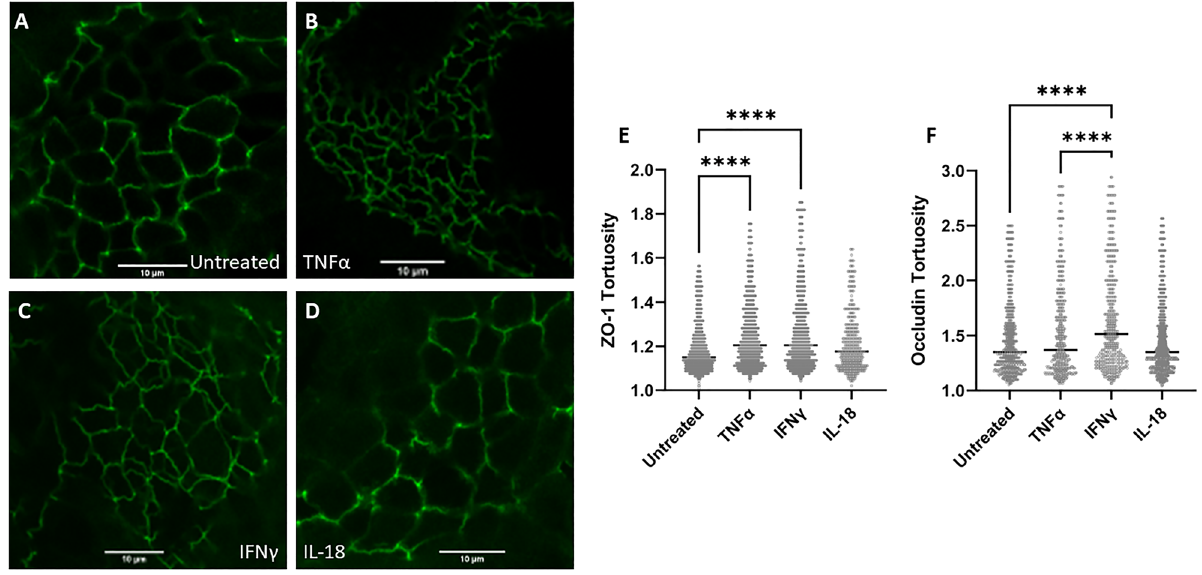
Figure 4. Cytokine treatment alters tight junction tortuosity. ( A–D ) Representative ZO-1 (Alexa Fluor 488) staining of bovine intestinal organoids using a ×100 objective lens following 24-h cytokine treatment. Scale bars denote 10 µm. ( E ) Quantification of ZO-1 tortuosity in cytokine-treated intestinal organoids. TNFα-treated bovine enteroids and IFNγ-treated bovine enteroids displayed a significant increase in junctional tortuosity (p < 0.0001 for each treatment) determined by Kruskal–Wallis non-parametric ANOVA (α = 0.05) utilizing Dunn’s post hoc analysis. ( F ) Quantification of Occludin tortuosity in cytokine-treated intestinal organoids. IFNγ-treated bovine enteroids displayed a significant increase in Occludin tortuosity (p < 0.0001) relative to all other treatments. **** denotes p < 0.0001.